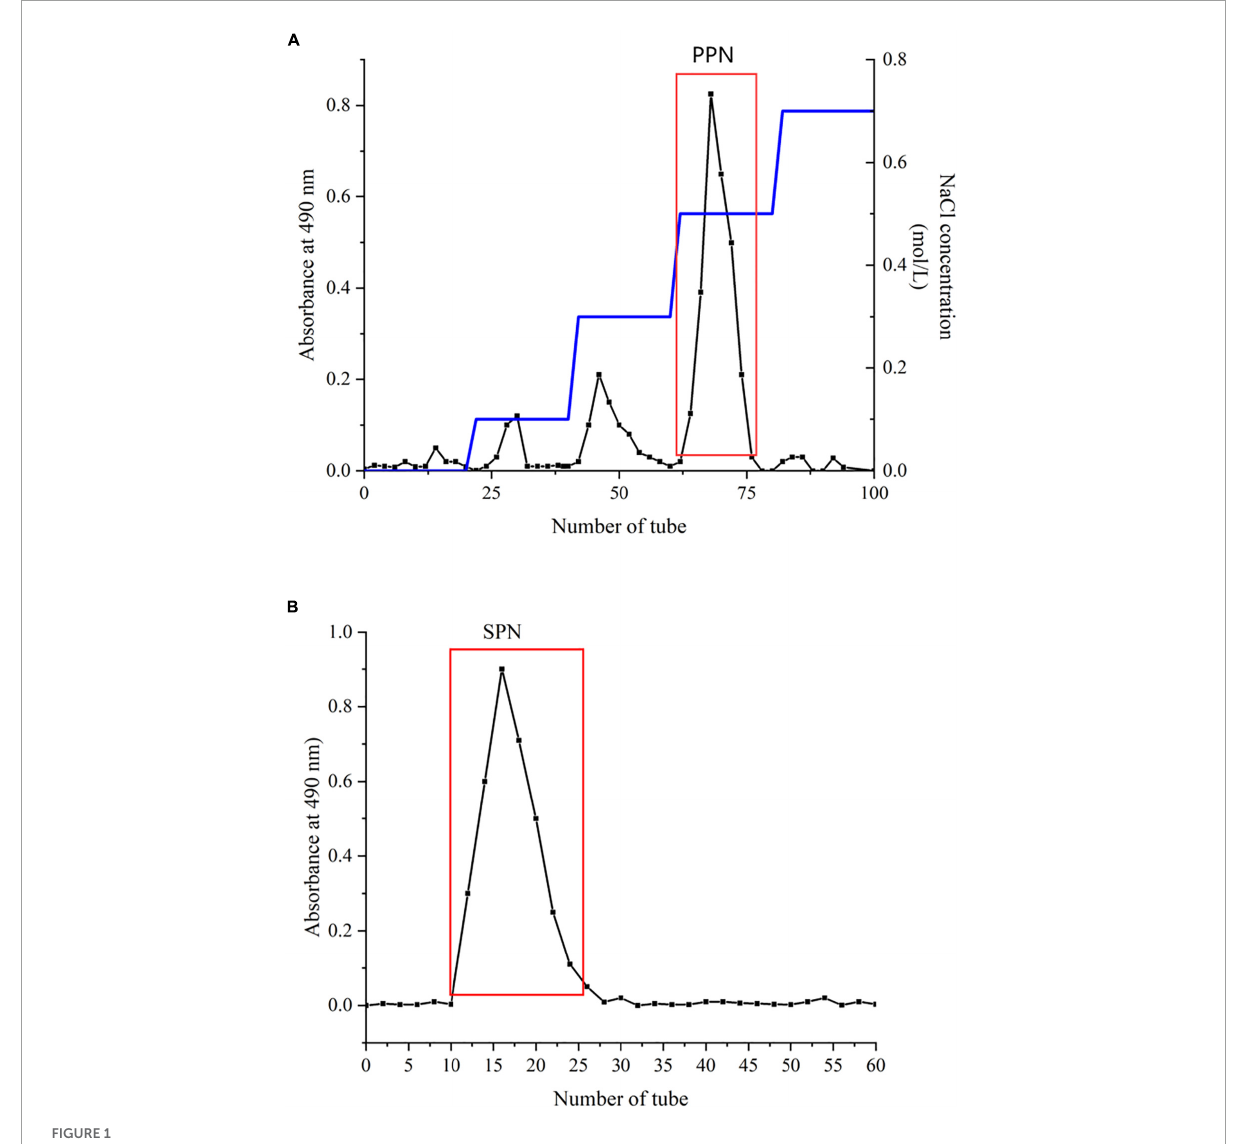
FIGURE1 Chromatography of SPN on DEAE-52 (A) and Sephadex G-100 (B)